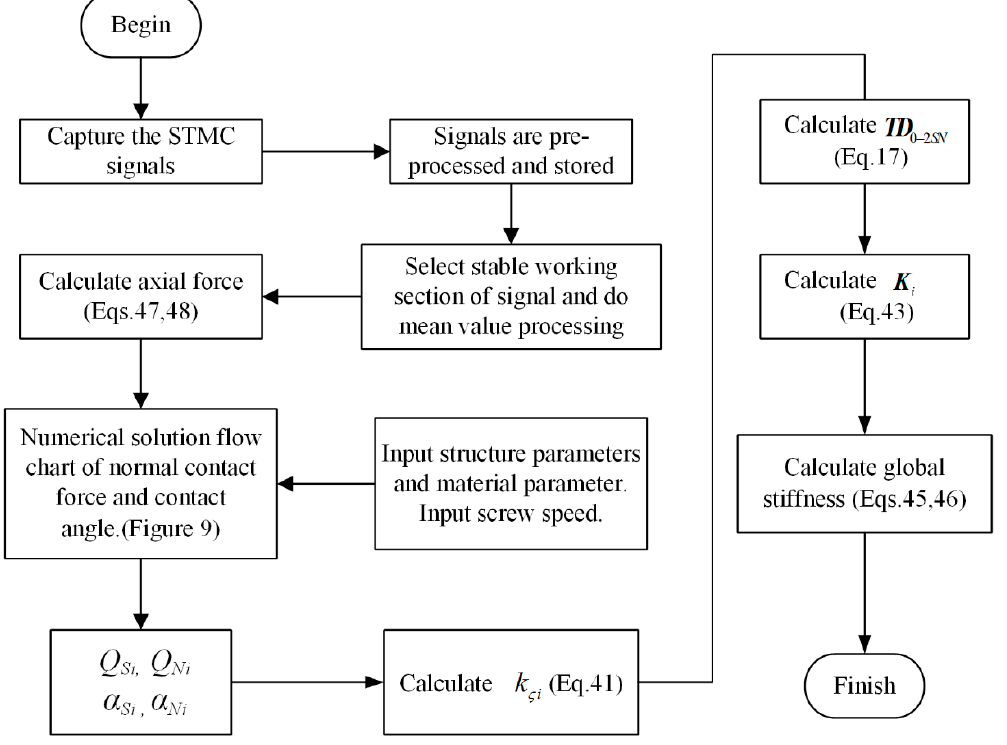
Figure 24. The flow chart of sensorless stiffness estimating method.